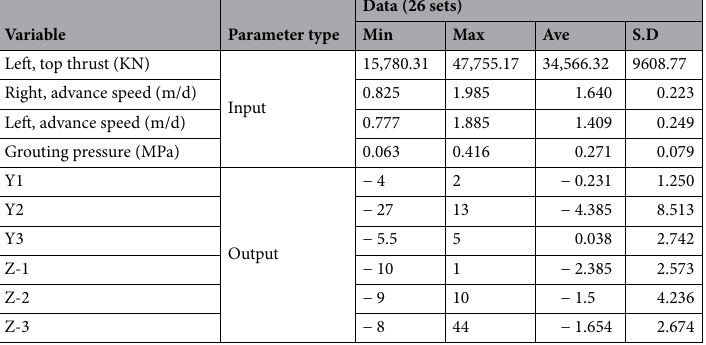
Table 2. Data set of lateral measuring points.